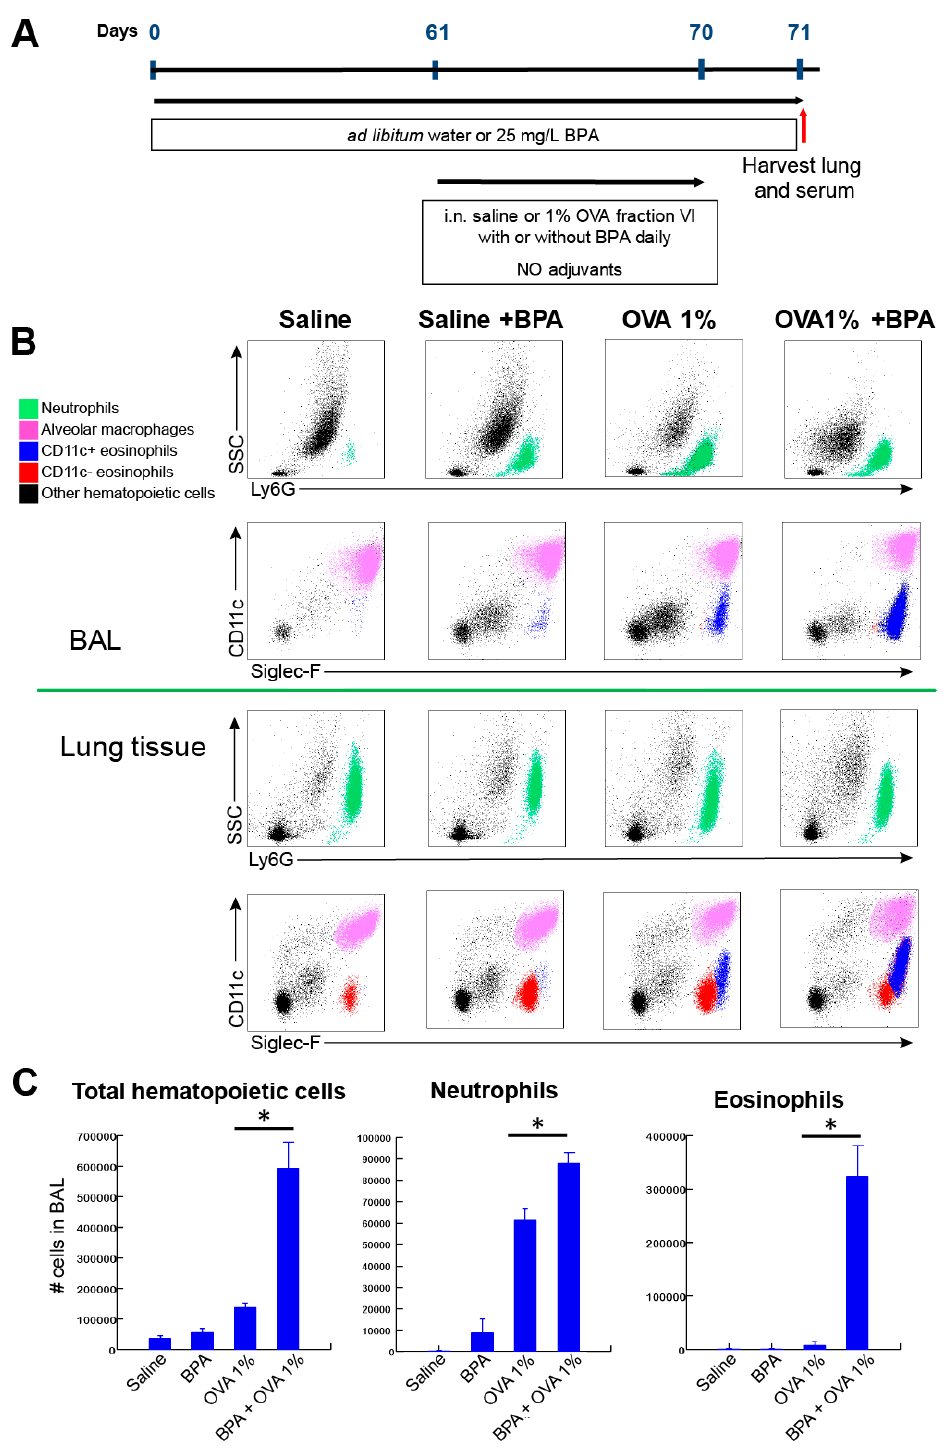
Figure 3. Chronic systemic exposure to BPA facilitates the development of allergic inflammation in a murine tolerogenic ovalbumin (OVA) treatment protocol. ( A ) BPA administration and OVA antigen challenge treatment timeline. ( B ) Flow cytometry analysis of leukocyte inflammatory response. Top charts, leukocyte populations measured in bronchoalveolar lavage; bottom charts, leukocyte responses measured in homogenized lung tissue. ( C ) Quantification of numbers of recruited cells in BALs by flow cytometry. N = 2 in saline group, N = 3-4 mice in treatment groups, all data shown from experiment performed one time. *, p < 0.05 by